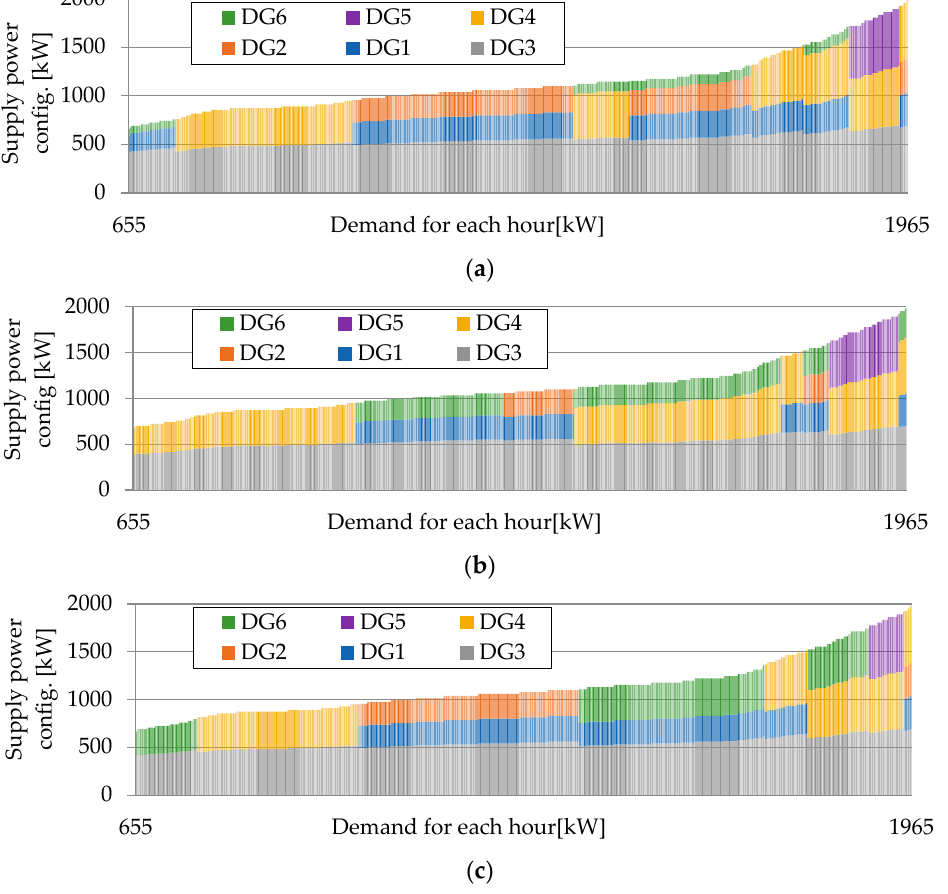
Figure 7. The load sharing pattern of the five units of medium-speed with one unit of high-speed DGs operated by the conventional load sharing method. ( a ) The five units of medium-speed + 200 kW the high-speed DG. ( b ) The five units of medium-speed + 500 kW the high-speed DG. ( c ) The five units of medium-speed + 800 kW the high-speed DG [kW].